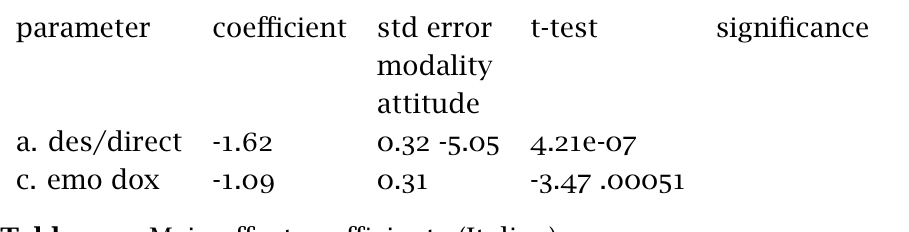
Main effect coefficients (Italian)